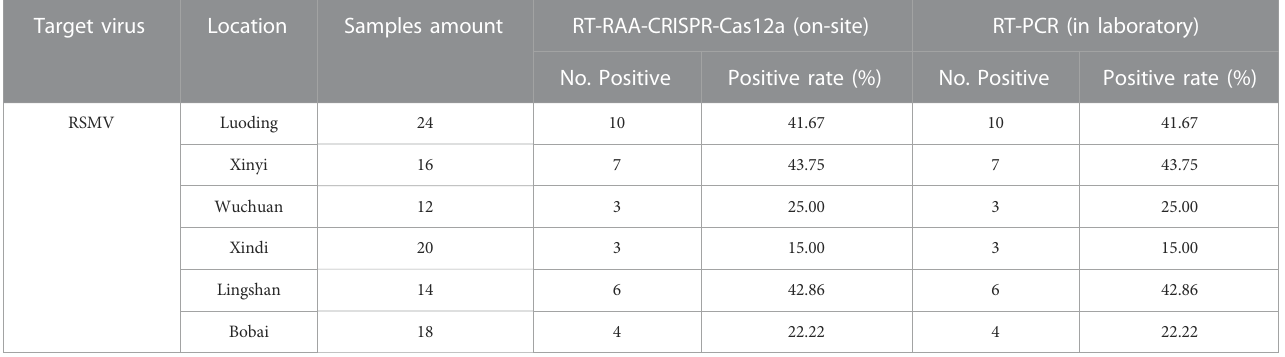
TABLE 2 Field samples detection for RSMV by two methods. Target